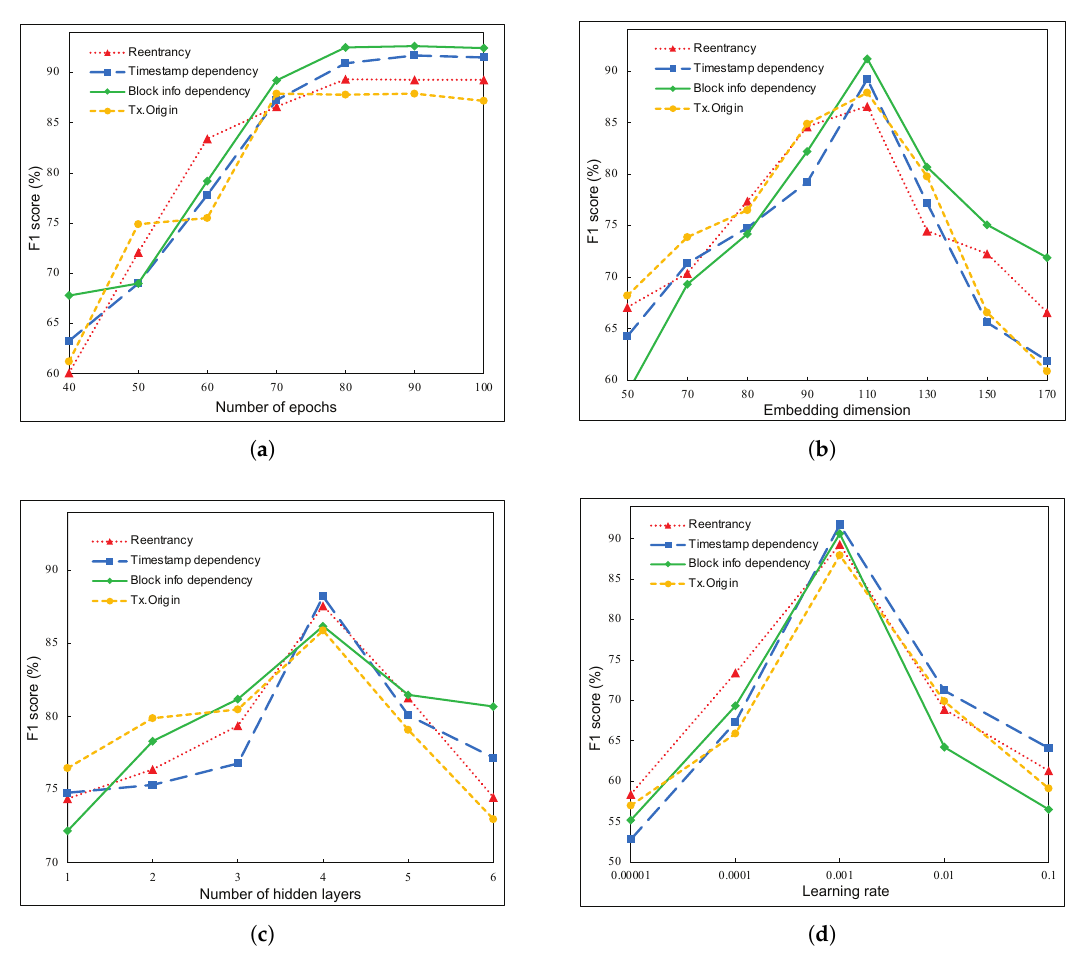
Figure 8. Impact of GMN key parameters in ASGVulDetector . ( a ) Impact of epochs. ( b ) Impact of embedding dimension. ( c ) Impact of number of hidden layers. ( d ) Impact of learning